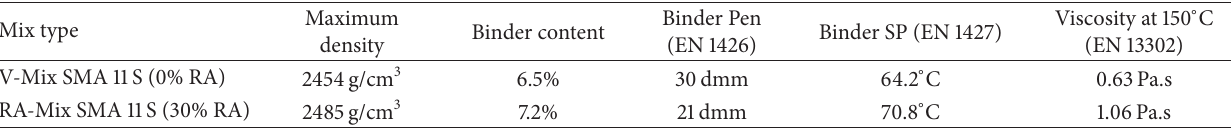
Table 1: Properties of V-Mix and RA-Mix.